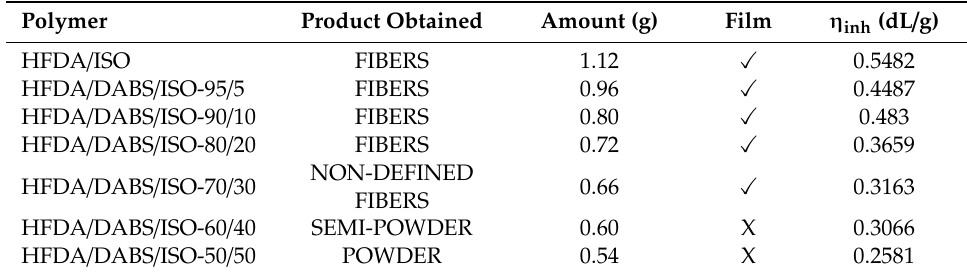
Table 1. Homopolymer and random copolymer prepared by